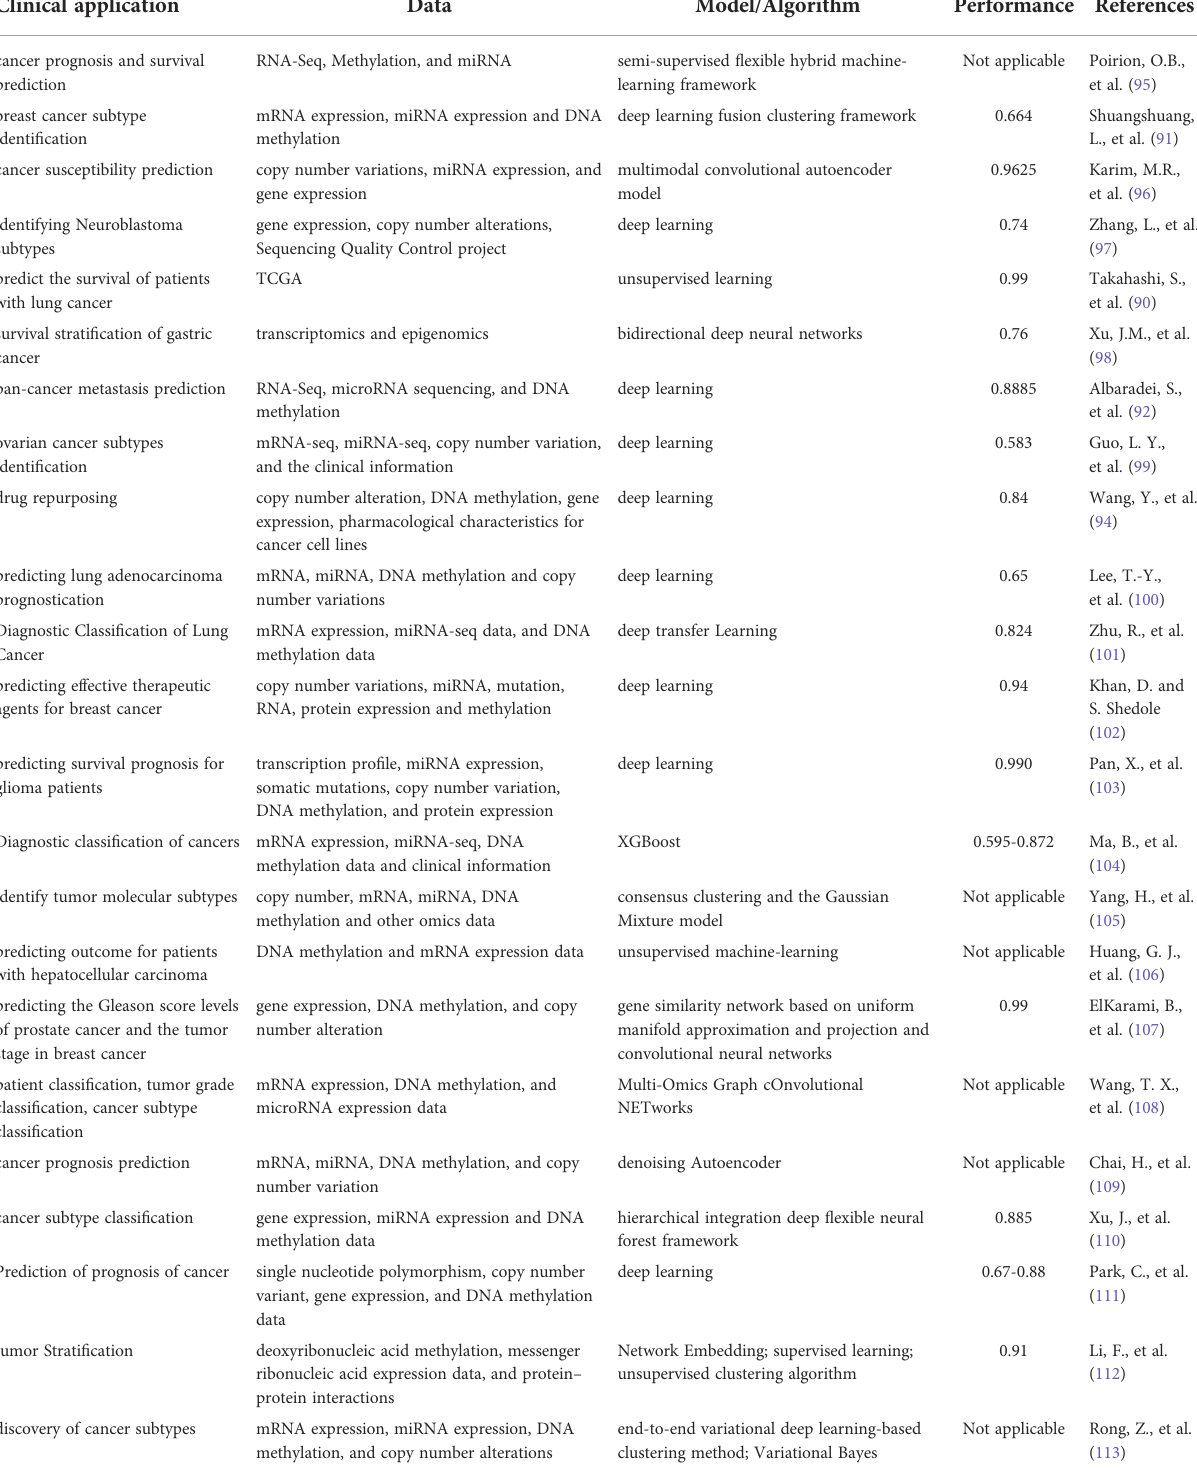
TABLE 2 Application of AI in the Integration of